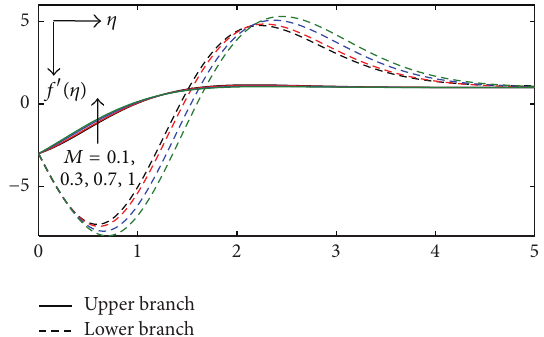
Figure 4: Variation of skin friction with 𝑠 for various values of 𝑀 with 𝛾 = 0.5 , 𝜆 = 0.5 , and Pr = 1 .